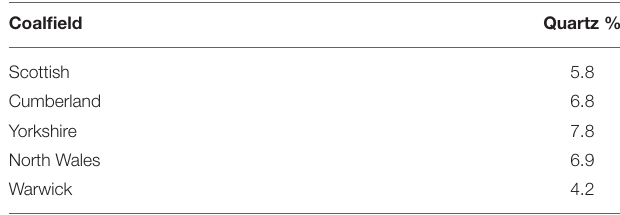
TABLE 3 | Compositional data for airborne dusts in a sample of British coal mines prior to